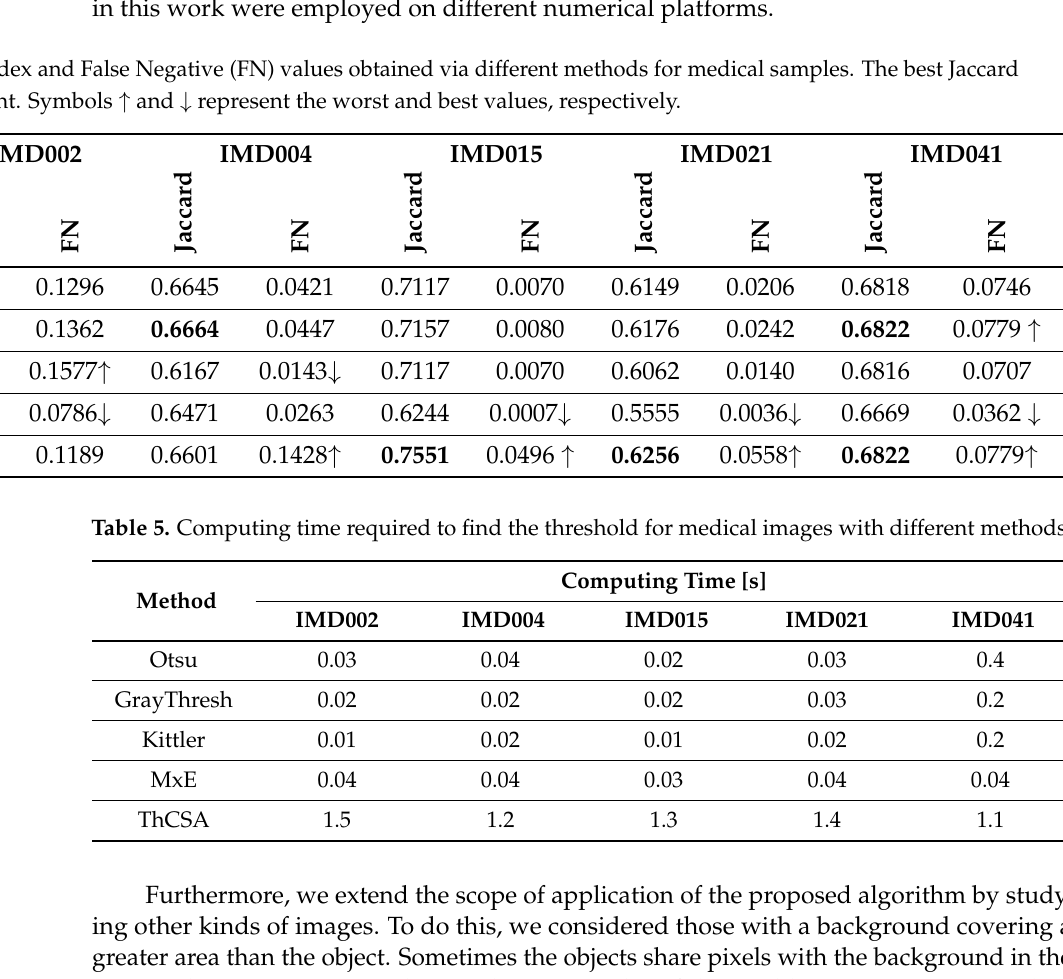
Table 4. Jaccard index and False Negative (FN) values obtained via different methods for medical samples. The best Jaccard index is in bold font. Symbols ↑ and ↓ represent the worst and best values, respectively.